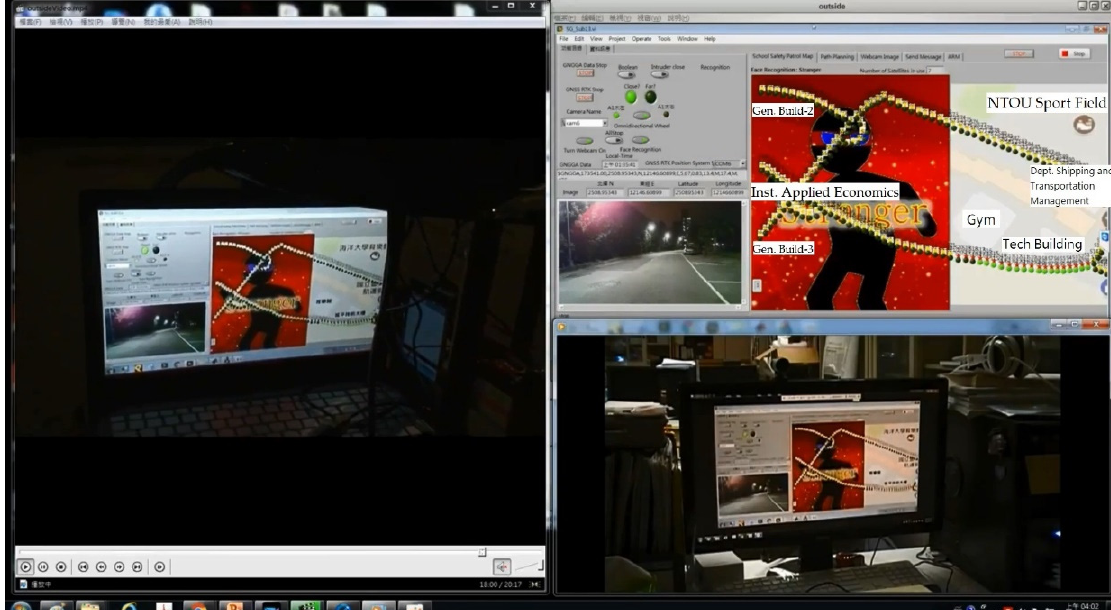
Figure 36. The robot patrolled in the night and identified the person passing by as a stranger.